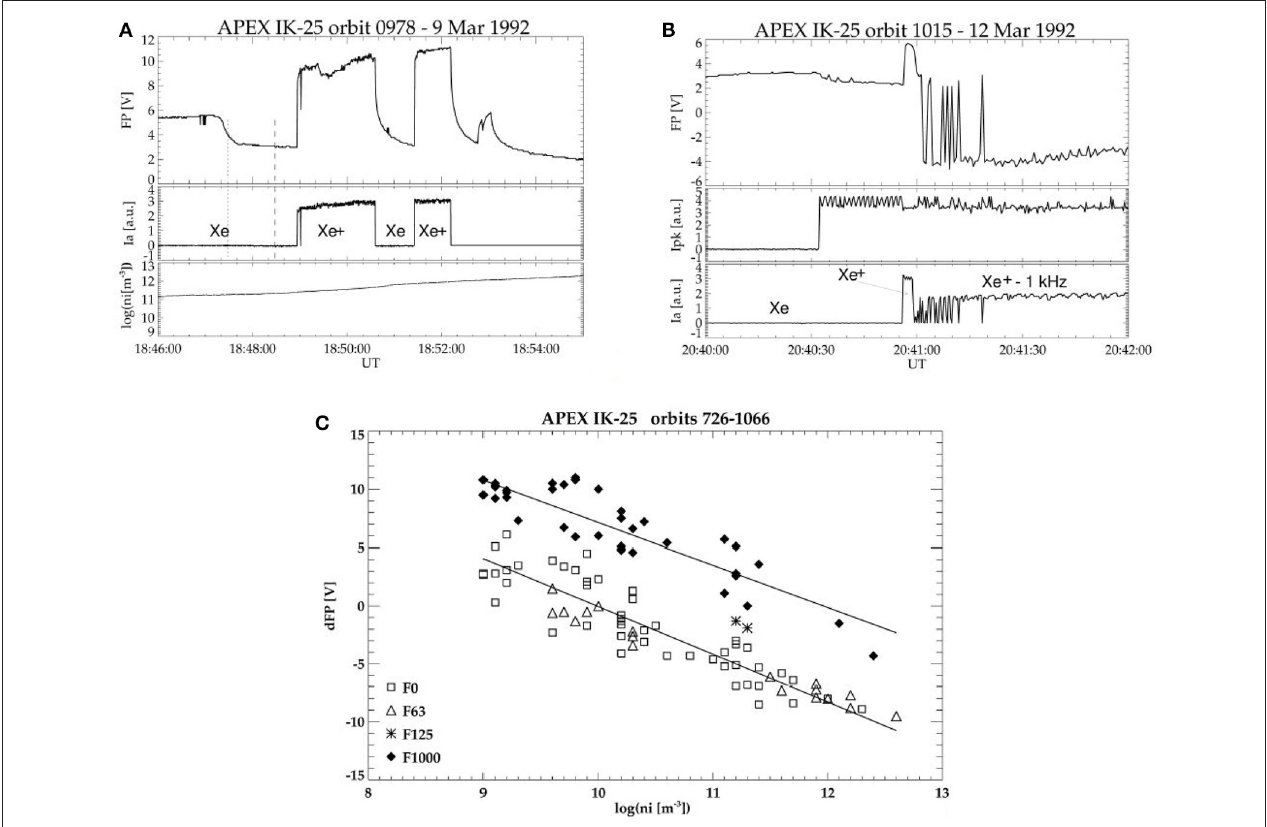
FIGURE 7 | Examples of the IK–25 spacecraft potential behavior during the xenon plasma injections. (A) (Night DC injection F0 mode at ∼ 440 km altitude) shows the KM–10 floating probe potential, the mean UPM ion current, and the ambient plasma density (KM–10). (B) (Dayside DC/1 kHz injection F1000 mode at ∼ 2,900 km altitude) depicts the KM–10 floating probe potential, the UPM hollow cathode current, and the mean UPM ion current (in both panels Xe stands for the neutral xenon release intervals, Xe+ for the xenon plasma injections). (C) Change of the spacecraft potential during the xenon plasma releases as a function of the ambient plasma density for different UPM modulation modes. (Reprinted from Prech et al., 1999, with permission from